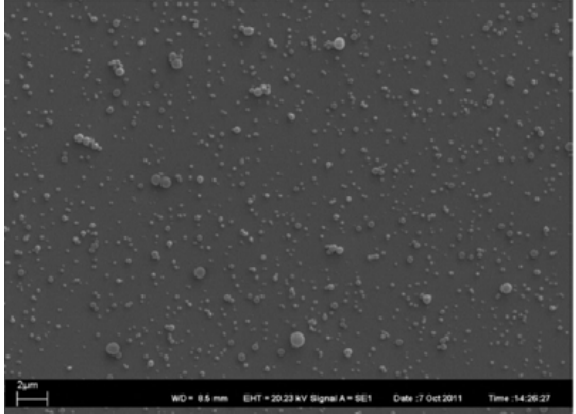
Figure 45. SEM image of C11BC5 SLN on SiO of 300 nm are shown [124].